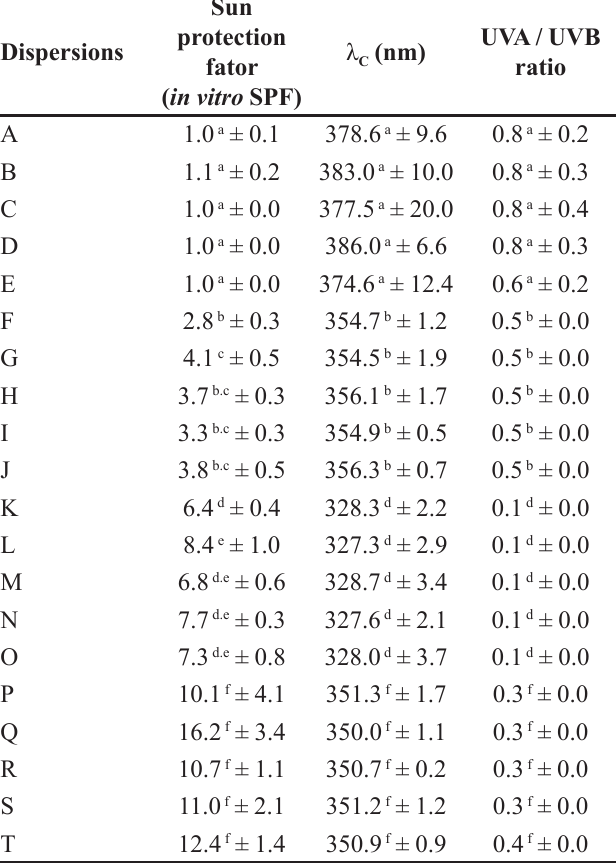
TABLE IV - Photoprotective efficacy in vitro for dispersions containing gelatin and gelatin microspheres, and UV filters alone or in combination. Values were expressed as mean ± standard deviation (n =